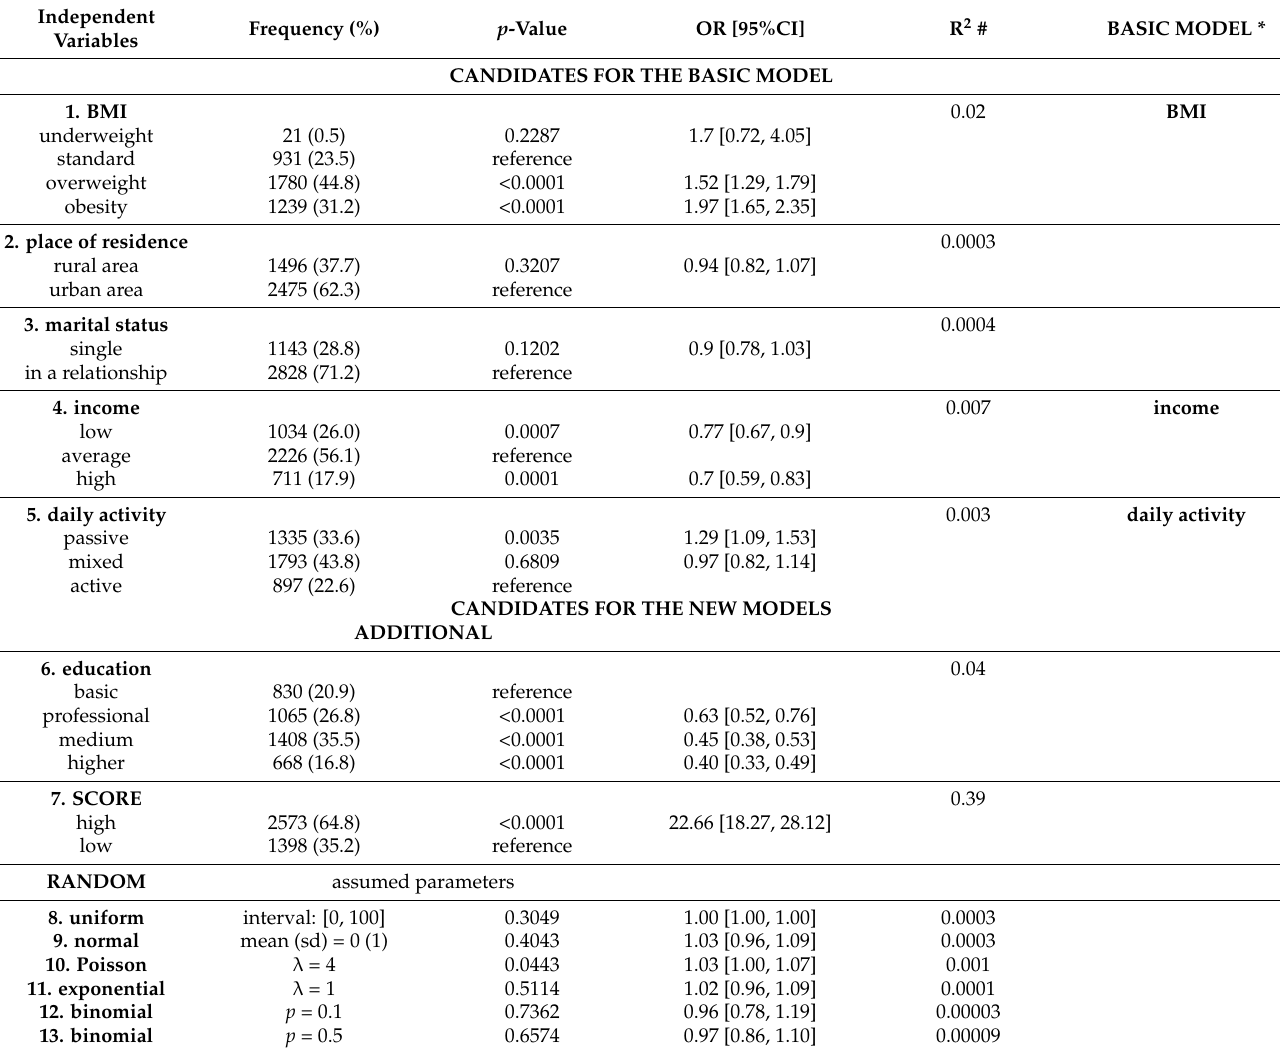
Table 4. Summary of results for one-dimensional logistic regression models describing CVD risk depending on BMI, place of residence, marital status, income, daily activity, education, SCORE result, and random variables with planned